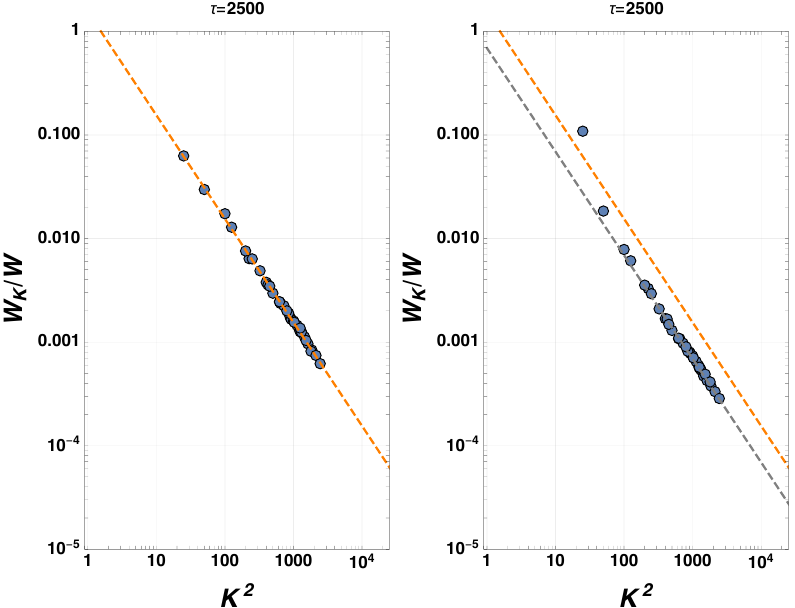
Figure 5. Case A1. Left-hand panel: inviscid. Right-hand panel: viscous. Log-log plots of W K / W (averaged over 250 time units) as a function of K 2 . The energy spectra are shown at τ = 2500, which corresponds to the relaxation time of the inviscid case (thermal equilibrium). The orange dashed line denotes the behavior ∼ 1/ K 2 of the non viscous regimes, while the gray dashed line is the viscous